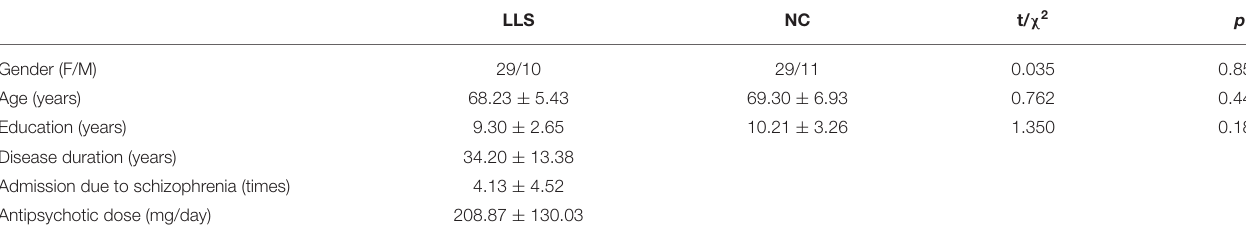
TABLE 1 | Demographic and clinical characteristics of late-life schizophrenia patients (LLS) and normal controls (NCs).